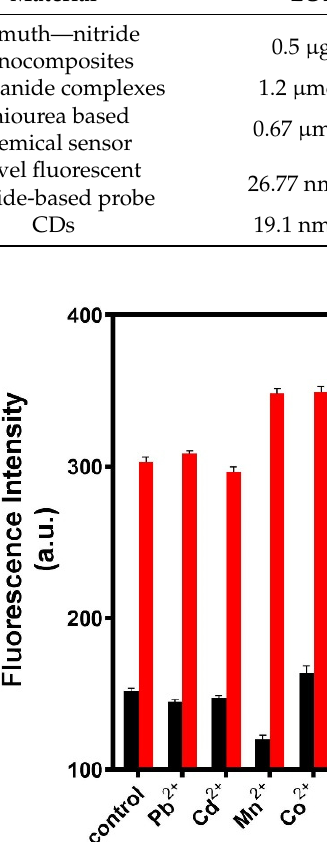
Figure 8. Specificity of the fluorescence probe for sensing Zn 2+